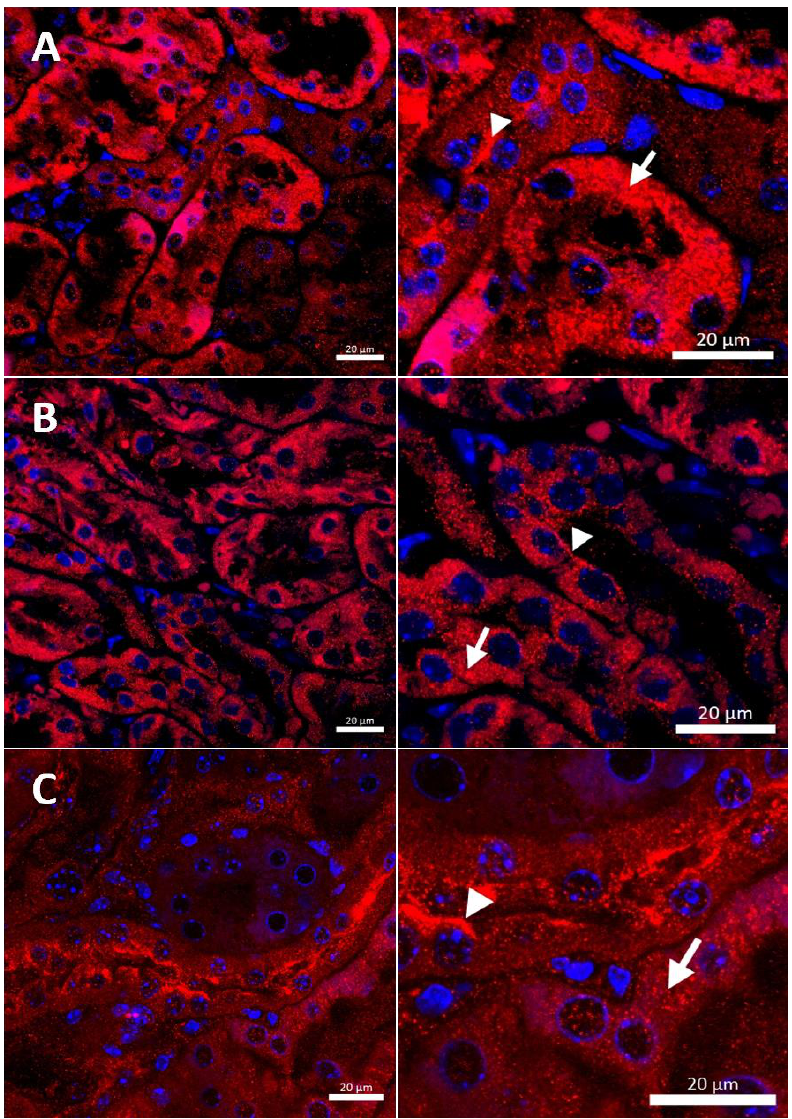
Figure 9. Immunofluorescent staining of CTR1 protein (red, channel) analyzed by confocal micros- copy in the kidney of the adult (6-month-old). Right panels show digital enlargement of CTR1 stain- ing visualized in left panels to reveal details of CTR1 cellular localization. This was performed using the ROI function of the ZEN programme: ( A ) W-t mouse, both apical (arrow-head) and cytoplasmic (visible as numerous red dots) (short arrow) localization of CTR1 protein in the epithelial cells of the proximal renal tubules. ( B ) Cupric chloride-administered w-t mouse, apical (arrow-head) and cytoplasmic (red dots) (short arrow) localization of CTR1 protein in the epithelial cells of the proxi- mal renal tubules. ( C ) Cupric chloride-treated mosaic mutant, strong immunopositive signal indi- cating for CTR1 protein expression detected in the apical membrane (arrow-head) and in the cyto- plasm (red dots) of the epithelial cells of the proximal renal tubules. Expression of CTR1 protein was also observed in the cytoplasm (short arrow) of the epithelial cells of the proximal renal tubules. Nuclei were counterstained with DAPI. Bars correspond to 20 μm.